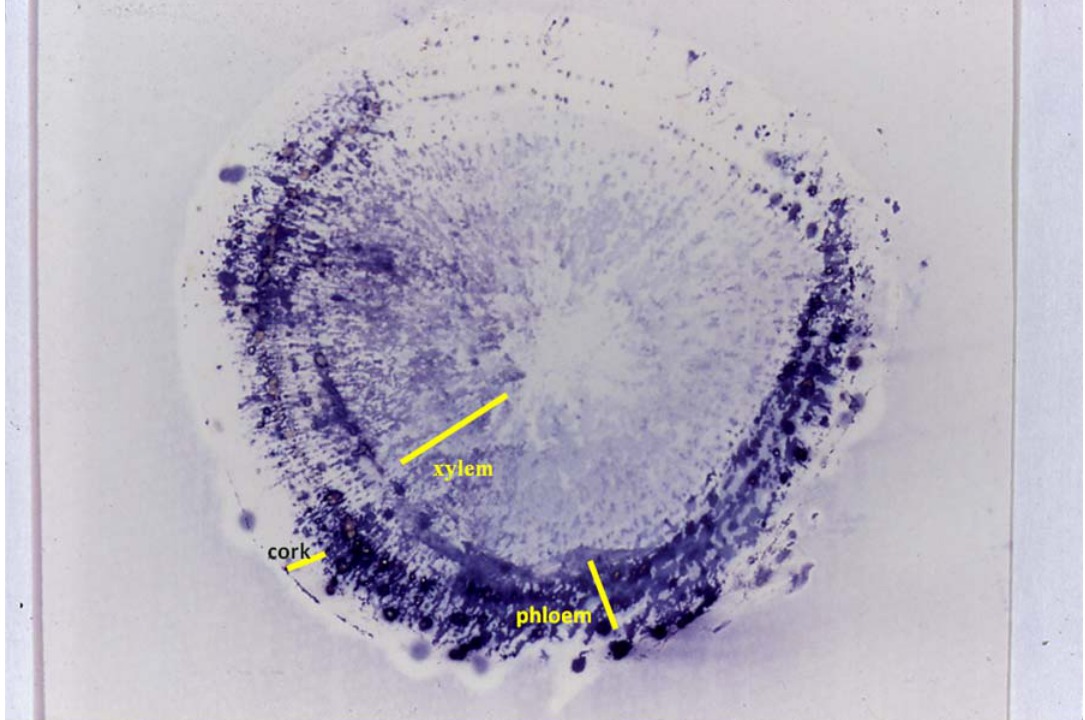
Figure 4. Immunocytolocalization of ginsenoside Rb1 in fresh Panax ginseng root using anti-ginsenoisde Rb1